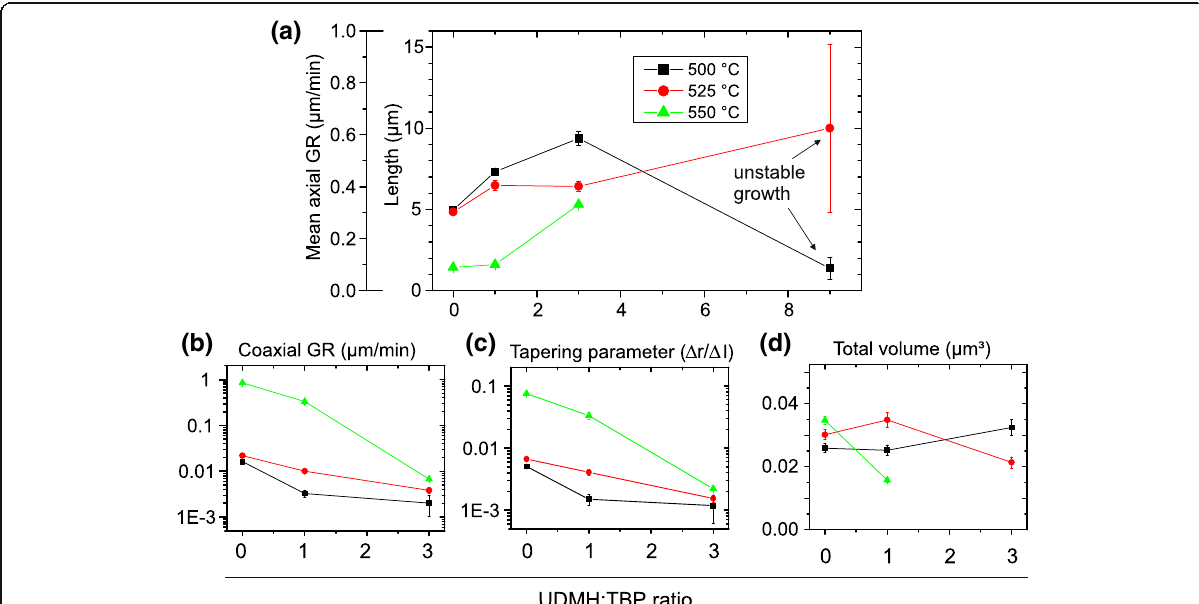
Fig. 2 Geometric characteristics of the NWs from Fig. 1 as a function of growth temperature and UMDH:TBP ratio: ( a ) length and mean axial growth rate, ( b ) coaxial growth rate, ( c ) tapering parameter, ( d ) total volume. Each measurement point represents an averaging of 10 to 20 NWs with the error bar representing the standard deviation or error propagation. The mean total volume of a NW in ( d ) was estimated assuming a truncated cone with circular